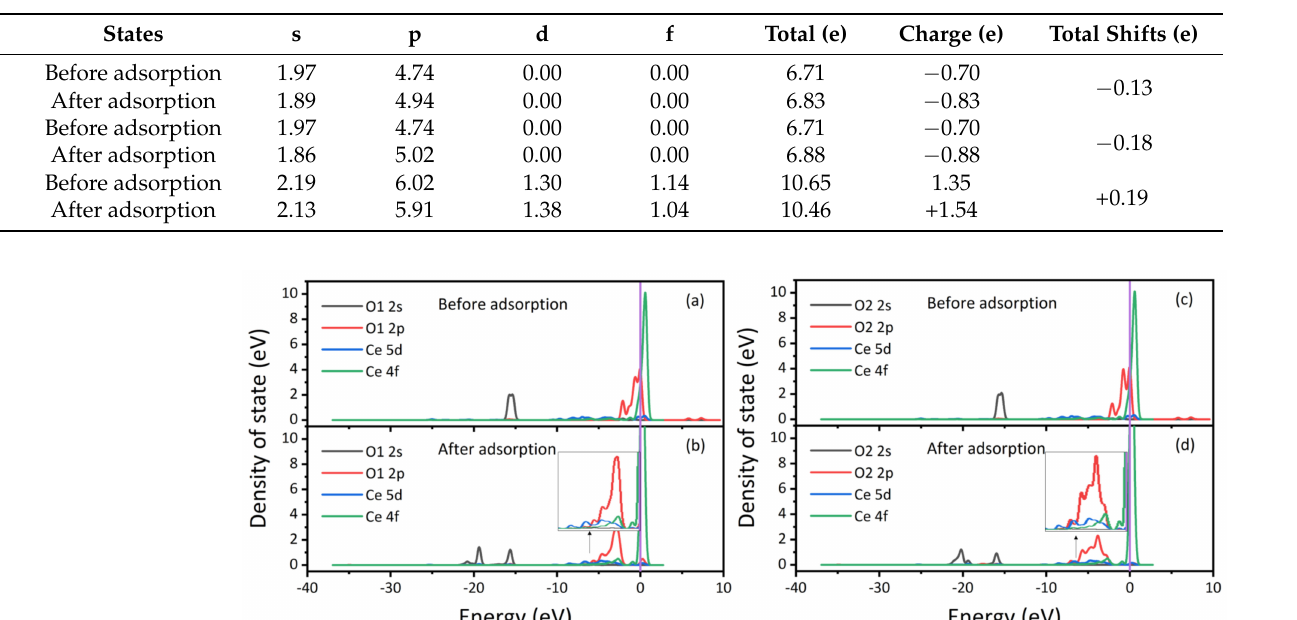
Table 7. The Mulliken population analysis of the bastnaesite (100) surface after adsorption (bidentate).